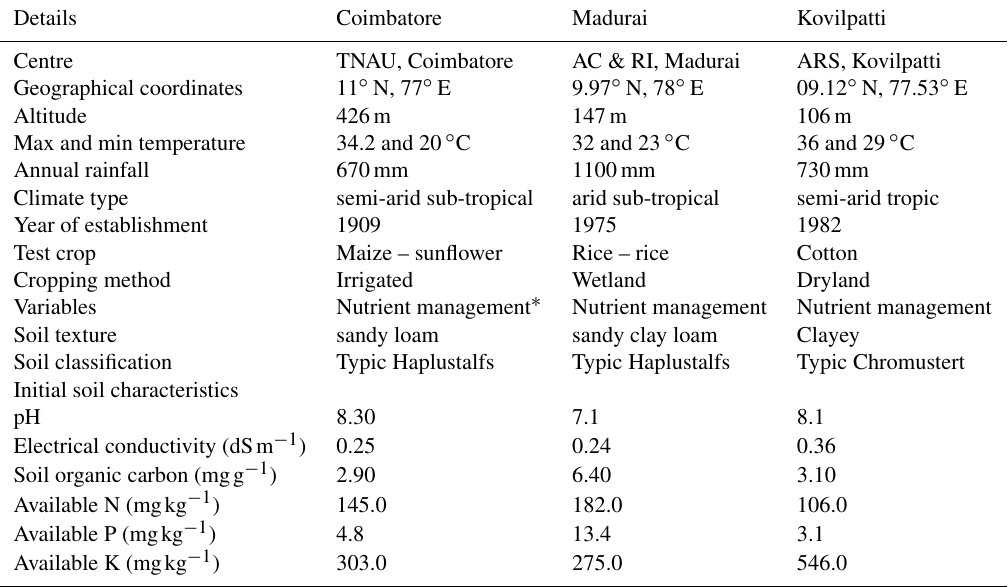
Table 1. Study area and soil